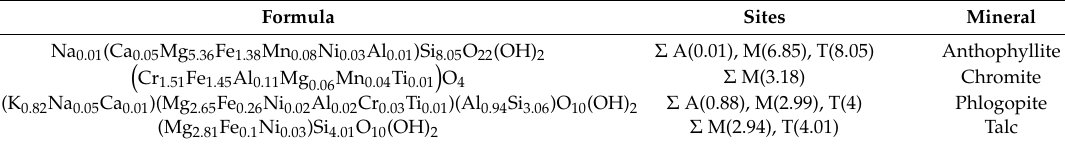
Table 2. The average mineral compositions from the amphibole zone (see Figure 6b).